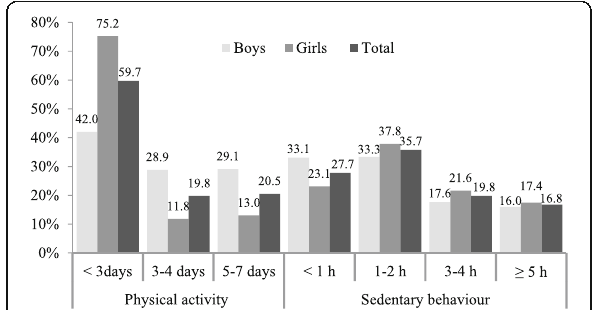
Fig. 1 Prevalence and duration of physical activity per week and sedentary behavior per day among